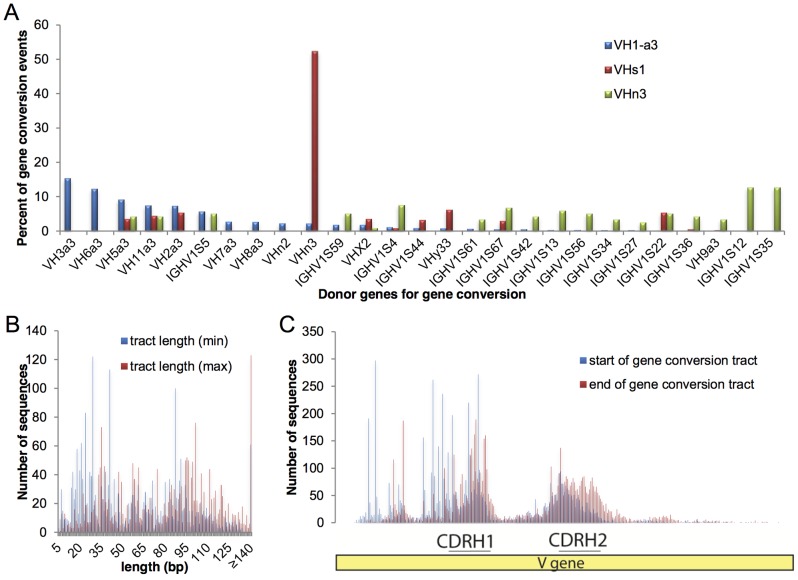
Gene conversion analysis.(A) Examination of gene conversion donor VH germline usage for recipient query sequences. For the recipient query sequences examined here, the germline VH usage (i.e. the original recombined V gene) was either VH1-a3, VHs1, or VHn3. (B) Gene conversion tract lengths (i.e. lengths of recombined fragments). See Materials and Methods for description of short (min) versus long (max) tract lengths. (C) The nucleotide positions along the VH gene sequence where the gene conversion recombination events start and stop. Start and end positions are based upon the short (min) tract as described in the Materials and Methods.